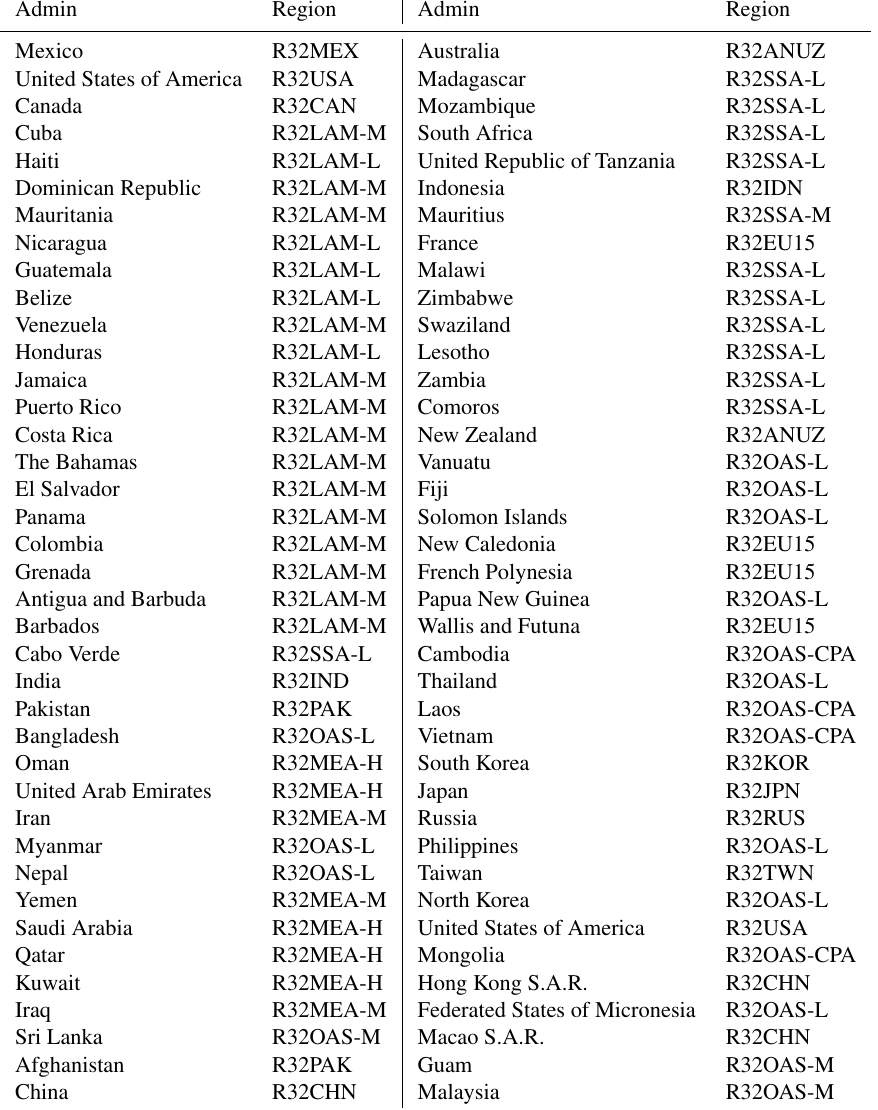
Table A5. Mapping countries to IIASA